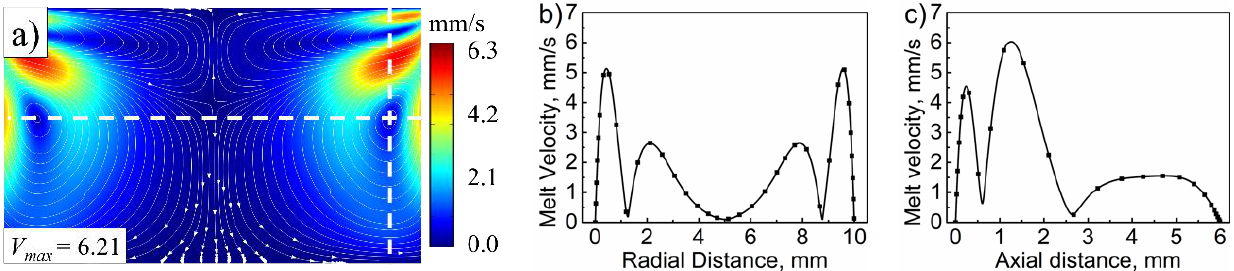
6 of 13 Figure 2. Specimen preparation and characterization. ( a ) Experimental procedures. ( b ) Segmenta-